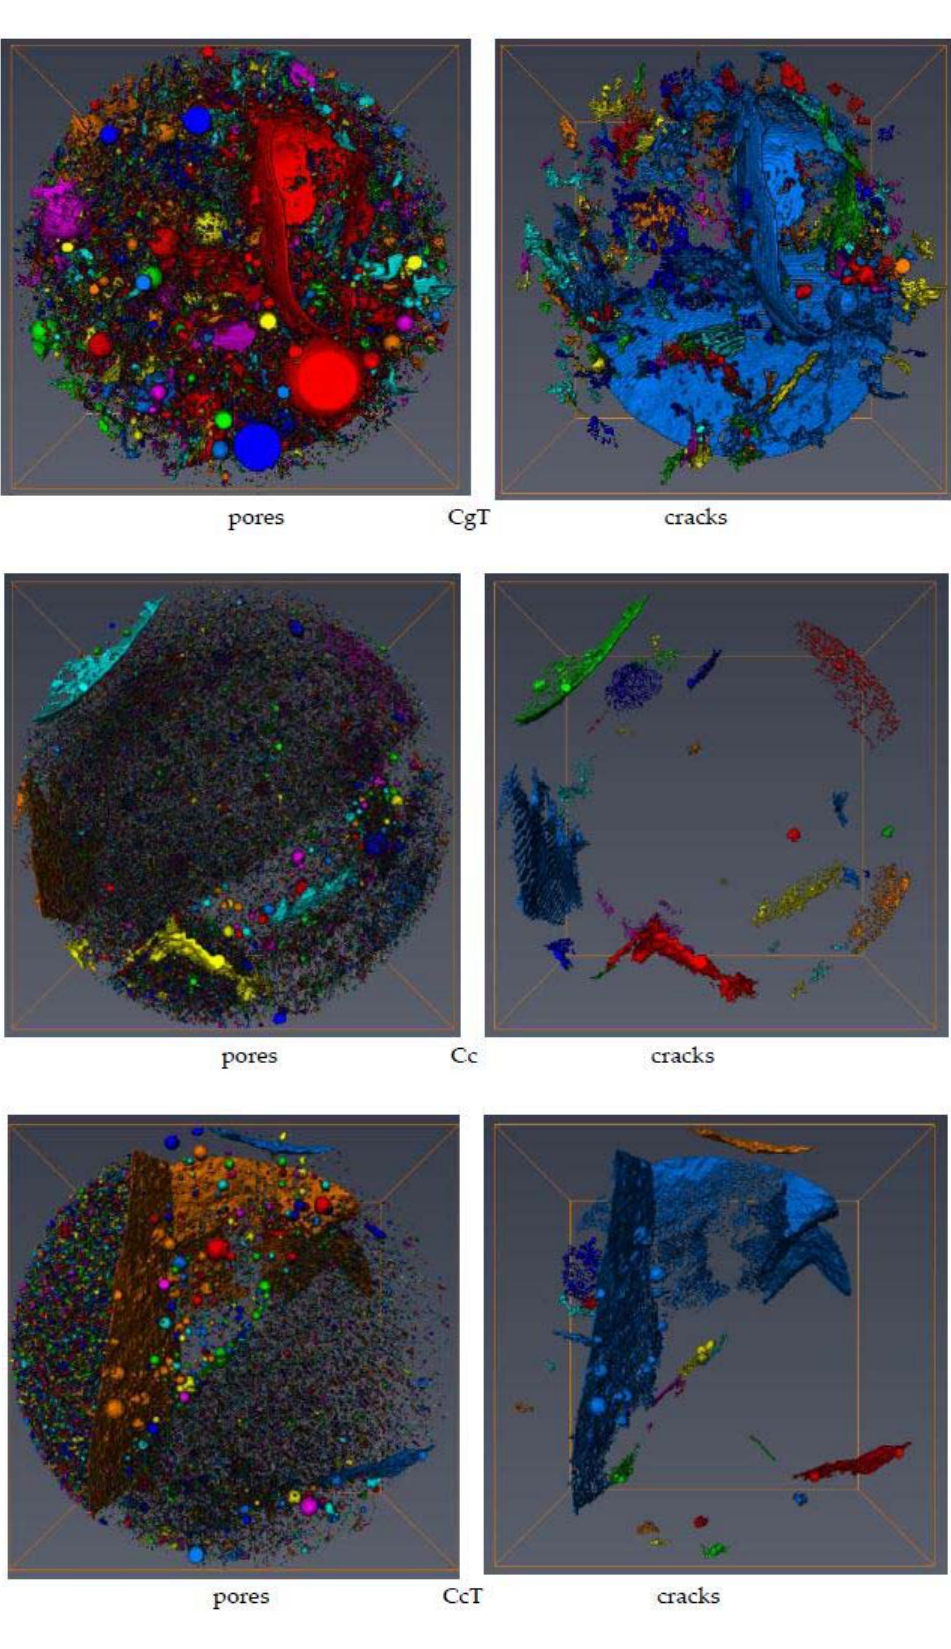
Figure 4. Microtomography (MCT) top view of the samples (diameter 4 mm) for the studied concretes showing all pores ( left ) and the separate cracks ( right ). Different colors mark individual spaces (pores or cracks) to better guide the eye. Abbreviations: C–concrete, g–granite, c–ceramics and T–heated.